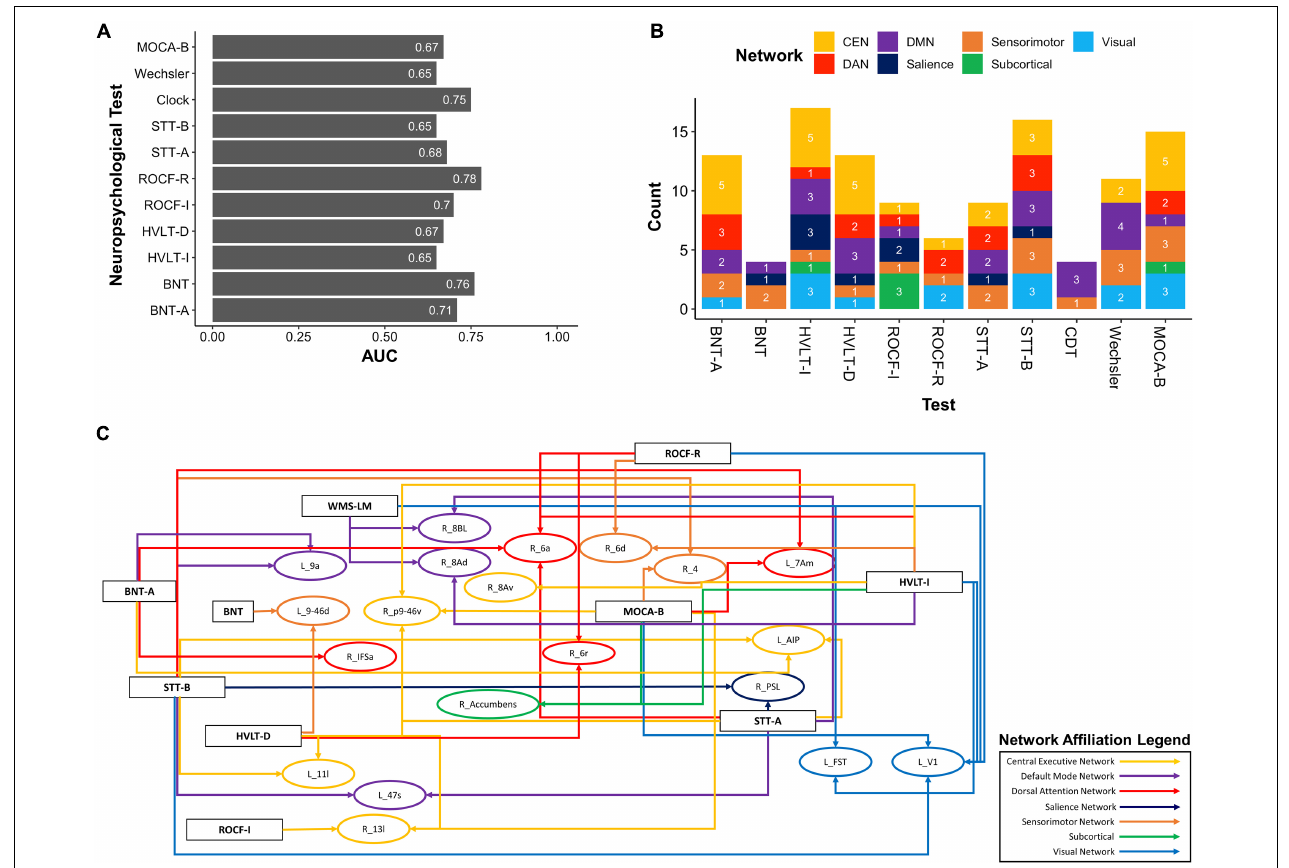
FIGURE 2 | Baseline resting-state fMRI parcels predicting deficits in neuropsychological tests. (A) 11 neuropsychological tests surpassed an AUC of 0.65. (B) Parcel to network mapping showed that parcels in the CEN and DMN were most frequently associated with poor performance in neuropsychological testing, though other networks were also represented. (C) Neuropsychological test to parcel mapping of twenty parcels which were predictors of at least two tests. The parcels have been placed in relative anatomical positions, while the colors of the arrows represent the networks associated with the parcels. Each arrow is drawn from the neuropsychological test (rectangle) to a single parcel (oval). CEN, Central Executive Network; DAN, Dorsal Attention Network; DMN, Default Mode Network; BNT-A, Boston Naming Test—Articulateness and Fluency; BNT, Boston Naming Test; HVLT-I, Hopkins Verbal Learning Test—Immediate Memory; HVLT-D, Hopkins Verbal Learning Test—Delayed Recall; ROCF-I, Rey Osterrieth Complex Figure Imitation; ROCF-R, Rey Osterrieth Complex Figure Recall; STT-A, Shape Trail Test—Part A; STT-B, Shape Trail Test Part